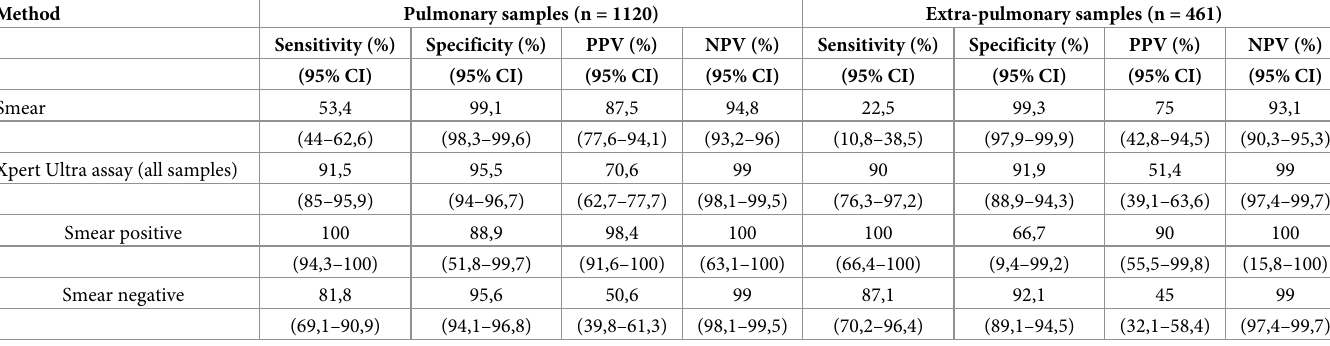
Table 2. Diagnostic performance of Xpert Ultra and smear using culture as the reference standard.